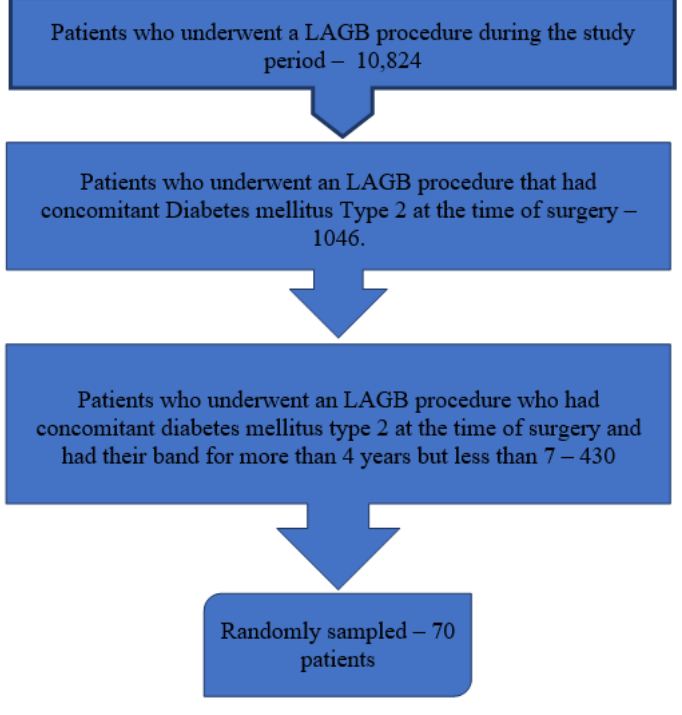
Figure 1. Study Population. LAGB, laparoscopic adjustable gastric banding. Table 1. Pre- and post-op comparisons.